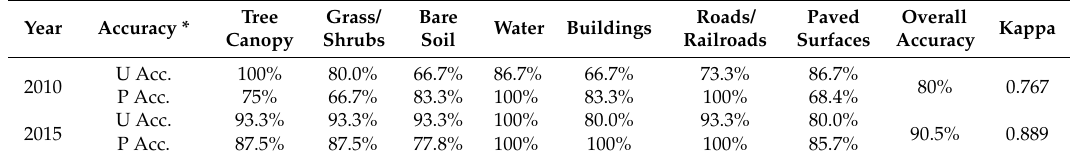
Figure 1. Landcovers of Philadelphia in 2008 [40] and 2015 featuring green infrastructure. Table 3. Accuracy scores of the 2010 and 2015 supervised classifications of